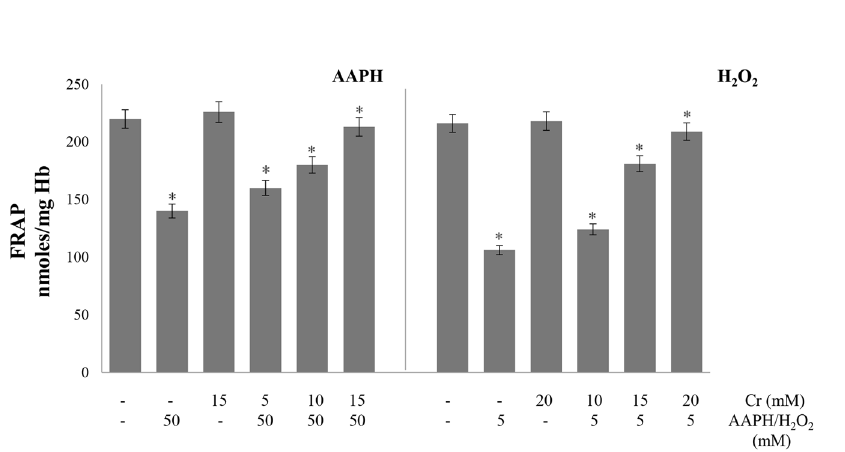
Fig 5. Effect of creatine on AAPH/ H 2 O 2 -induced changes in ferric reducing ability of cells. Erythrocytes were treated with the indicated concentrations of H 2 O 2 /AAPH, in presence and absence of Cr. FRAP assay was done in hemolysates. Results are mean values ± SEM from six independent experiments using blood from different donors. * Significantly different from control (p <